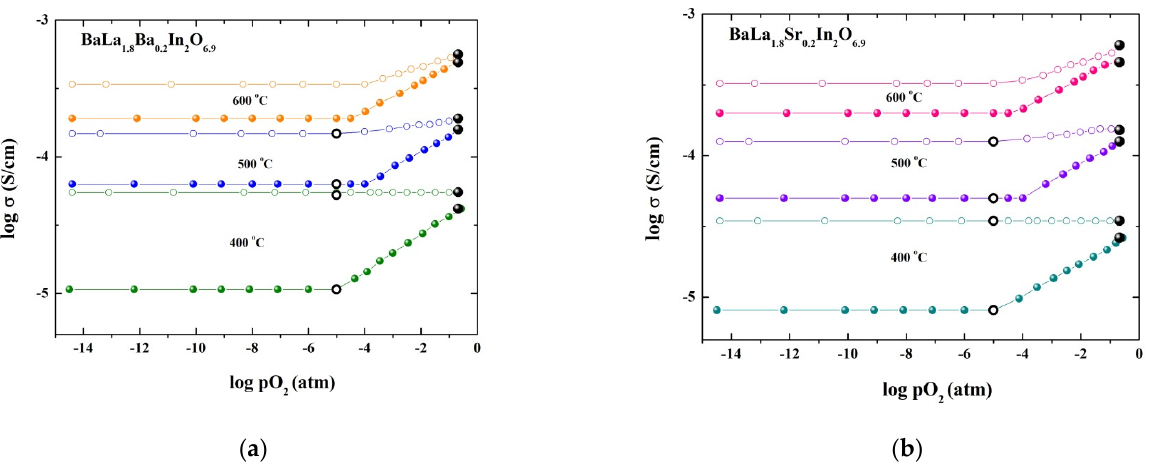
Figure 6. The dependencies of the conductivity values vs. oxygen partial pressure for the compositions BaLa 1.8 Ba 0.2 In 2 O 6.9 ( a ) and BaLa 1.8 Sr 0.2 In 2 O 6.9 ( b ) under dry (filled symbols) and wet (open symbols) conditions and conductivity values from σ –10 3 /T dependencies under wet air (filled black symbols) and wet Ar (open black symbols) conditions.